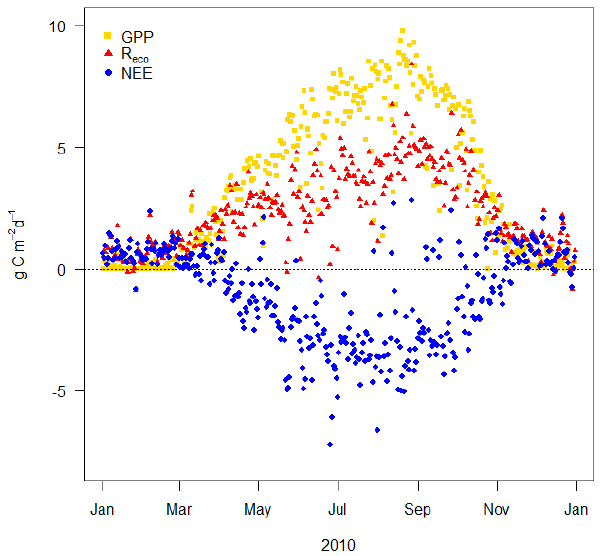
Fig. 1. Eddy covariance measured and derived C fluxes (gCm − 2 d − 1 ) . Blue dots show NEE, with negative values indicat- ing days in which the ecosystem is acting as a sink of C. Red trian- gles and green squares represent daily R eco and GPP obtained from flux partitioning of NEE data via LUT